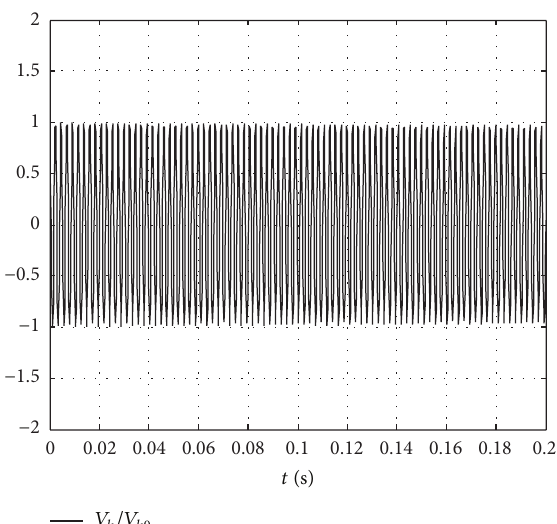
Figure 5: Displacement versus time plot of the generalized coor- dinate of the beam without piezoelectric attachment, 𝑈 = 95 m/s, (0) = 𝑞 𝑞 (0) = 𝑞 𝑞 ℎ ℎ0 , and 𝑡 𝑡0 .